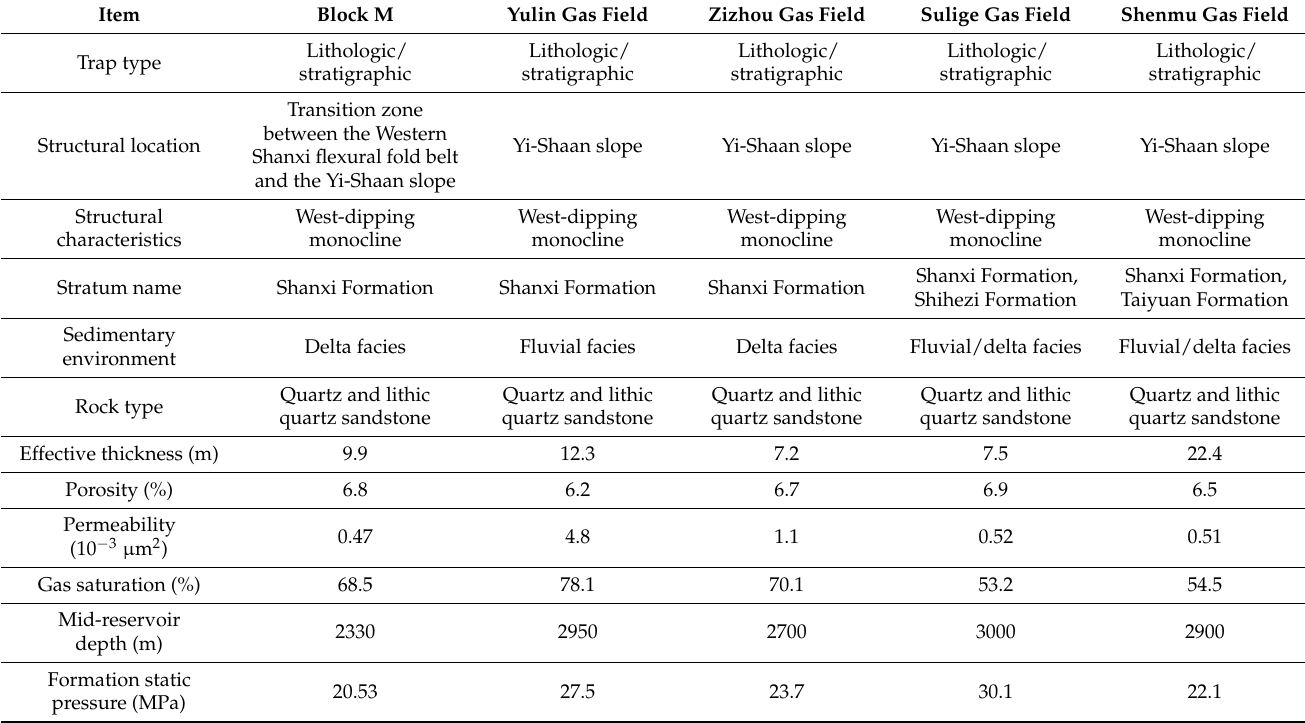
Table 2. Comparison of parameters between Block M and adjacent blocks in Ordos